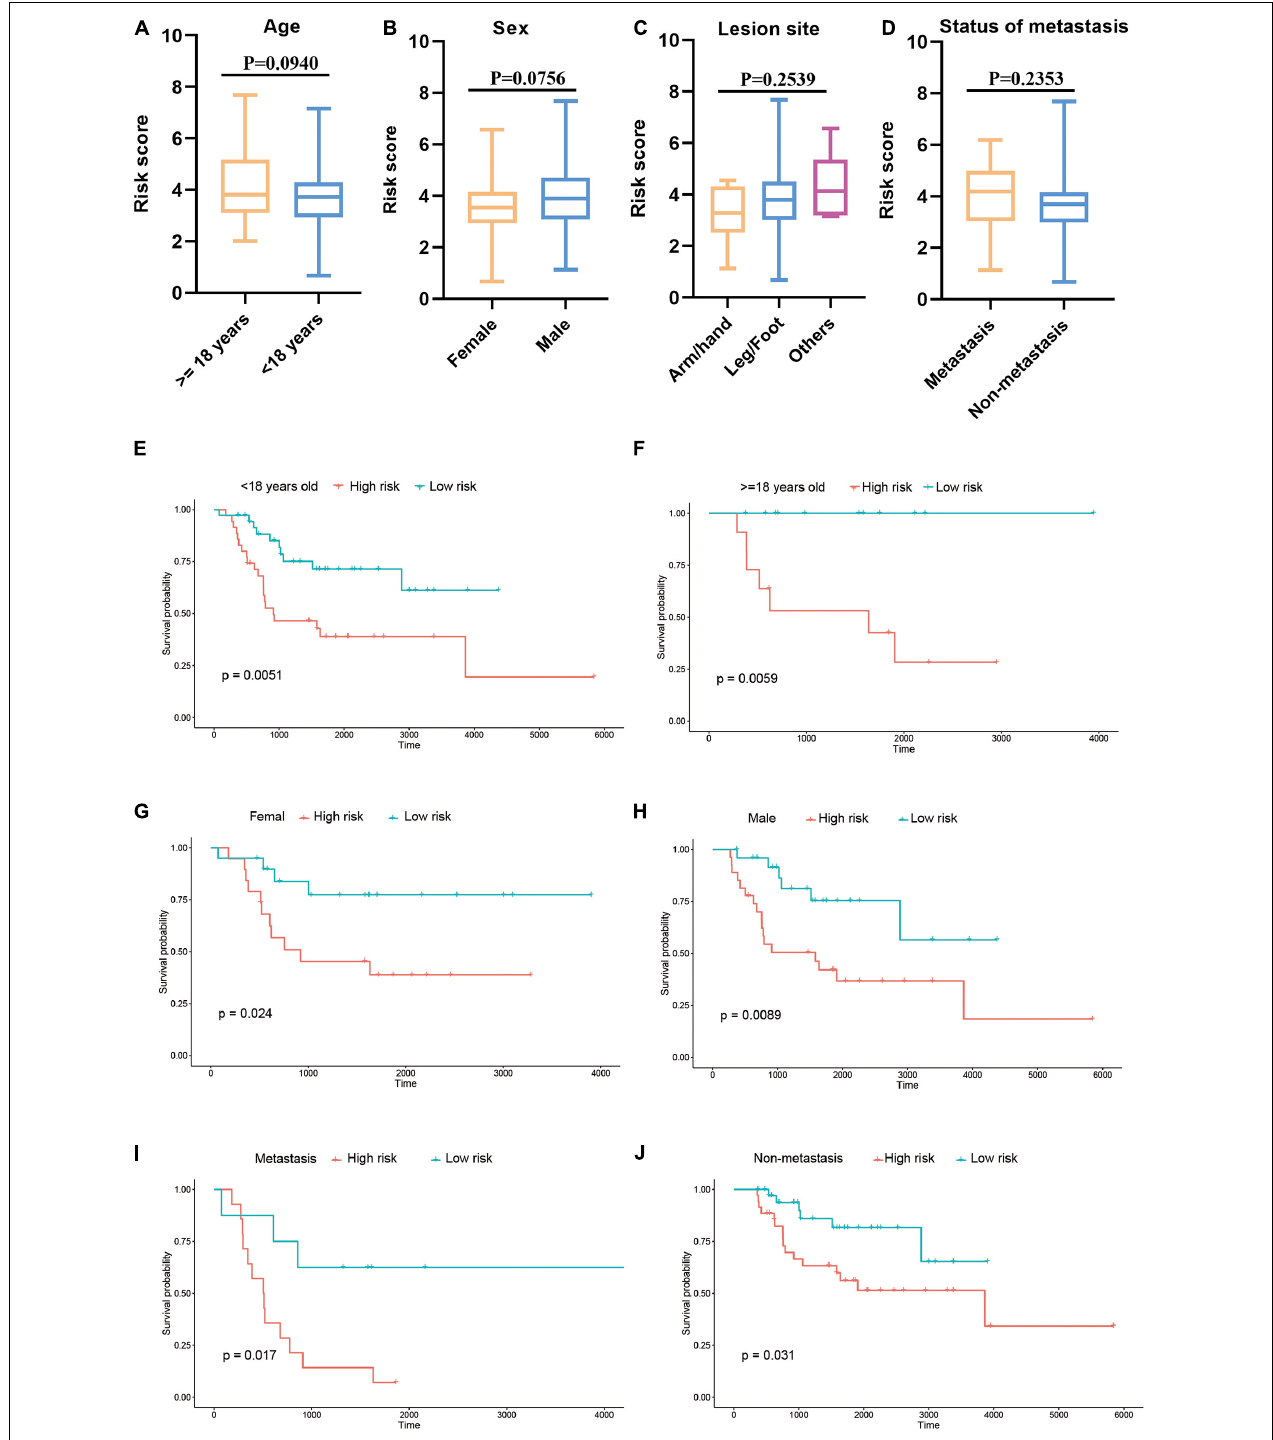
FIGURE 6 | Association of risk score and clinical characteristics (A–D) . No significant difference was identified in patients with different age (A) , sex (B) , lesion site (C) and metastasis status (D) . Independence analysis of the risk model (E–J) . Survival curve of patients regrouped according to age (E,F) , sex (G,H) , and metastasis (I,J)